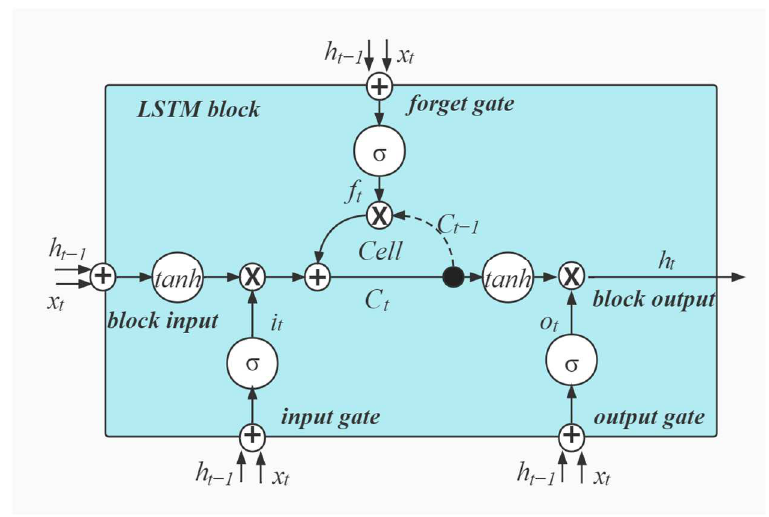
Figure 1. Schematic diagram of LSTM cell structure.